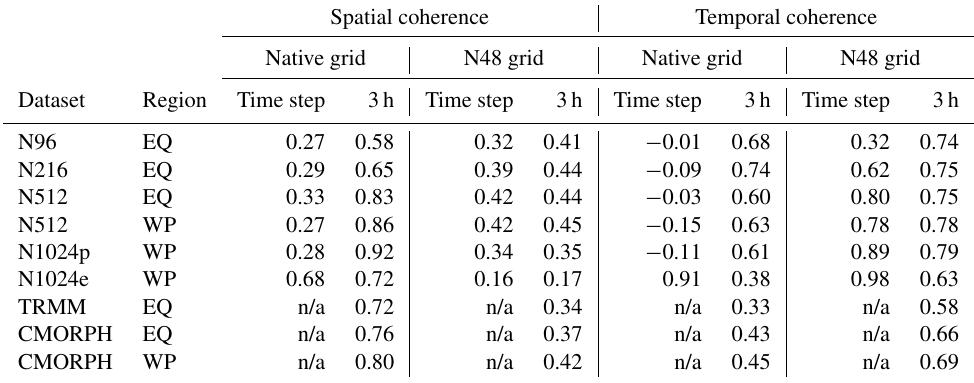
Table 3. Summary metrics of spatial and temporal coherence in precipitation using time step and 3h data on the native horizontal grid and averaged to the N48 (3 . 75 ◦ × 2 . 5 ◦ ) grid. Positive values indicate that coherence is more common than intermittency. Higher positive (negative) magnitudes indicate stronger coherence (intermittency). The time step column is marked “n/a” for TRMM and CMORPH because these datasets exist only as 3h